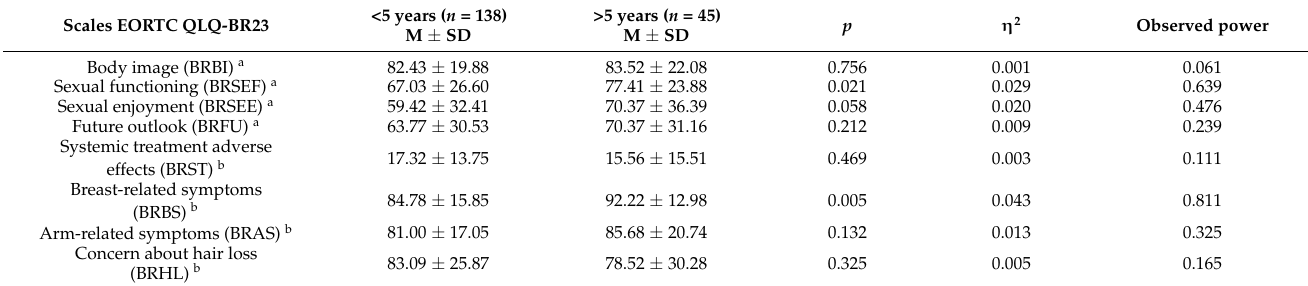
Table 7. Mean score of all items in EORTC QLQ-BR23 of the study group (<5 years from diagnosis to QOL measurement vs. >5 years from diagnosis to QOL